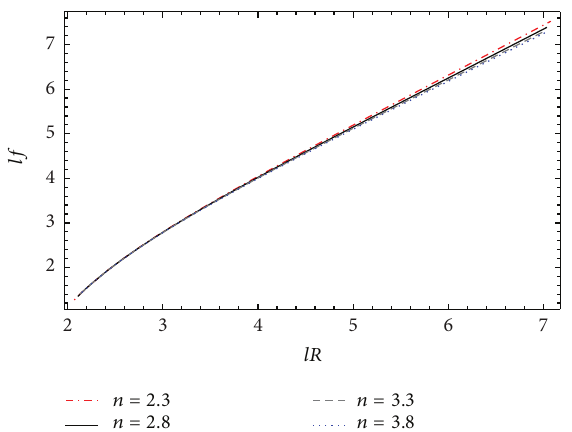
Figure 2: Reconstructed 𝑓(𝑅) for NADE in 𝑙𝑓 − 𝑙𝑅 plane with 0 ⩽ 𝑧 ⩽ 10 .